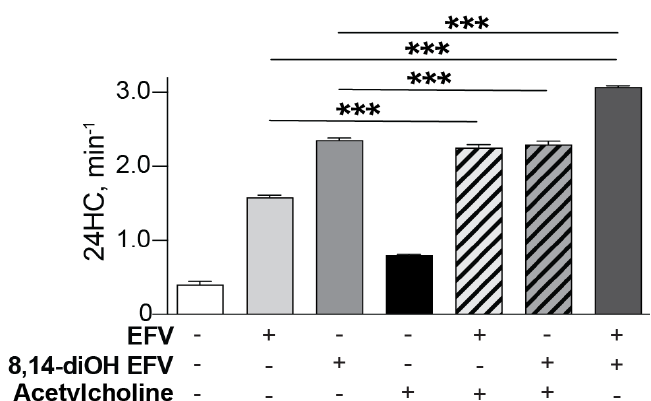
Figure 7. CYP46A1 activation in vitro in the presence of different compounds. CYP46A1 activity is presented as nanomoles of 24-hydoxycholsterol (24HC) formed per nmole of CYP46A1 per min. The results are the mean ± SD of the measurements from the three independent experiments. *** p ≤ 0.001 as assessed by a two-tailed unpaired Student’s t -test. 8,14-diOH EFV,